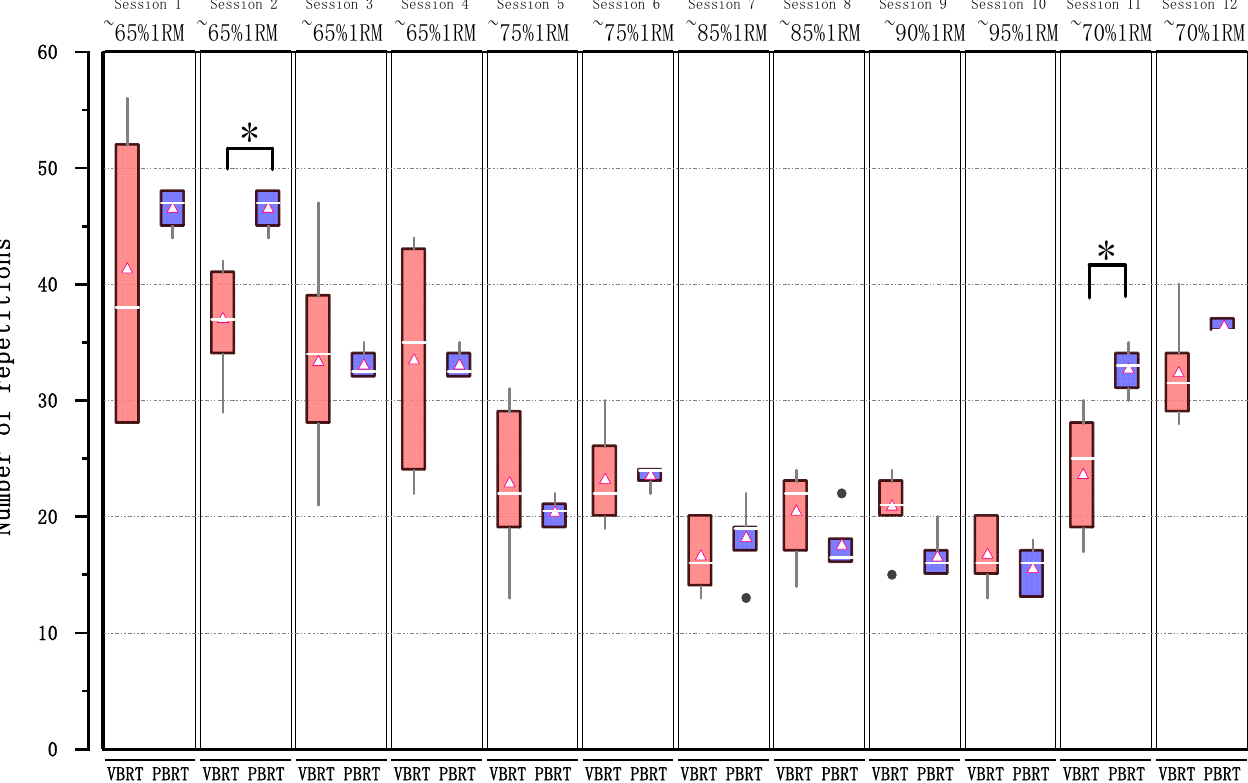
Figure 1. Number of repetitions in the squat exercise performed between VBRT and PBRT. Data are mean ± SD. VBRT: velocity-based resistance training. PBRT: percentage-based (%1RM) resistance training. Statistically significant differences between groups: * p < 0.05.